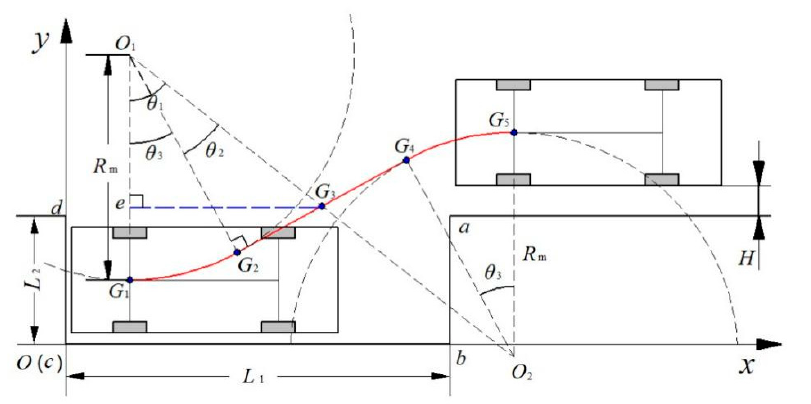
Figure 10. Arc- line-arc parallel parking path.